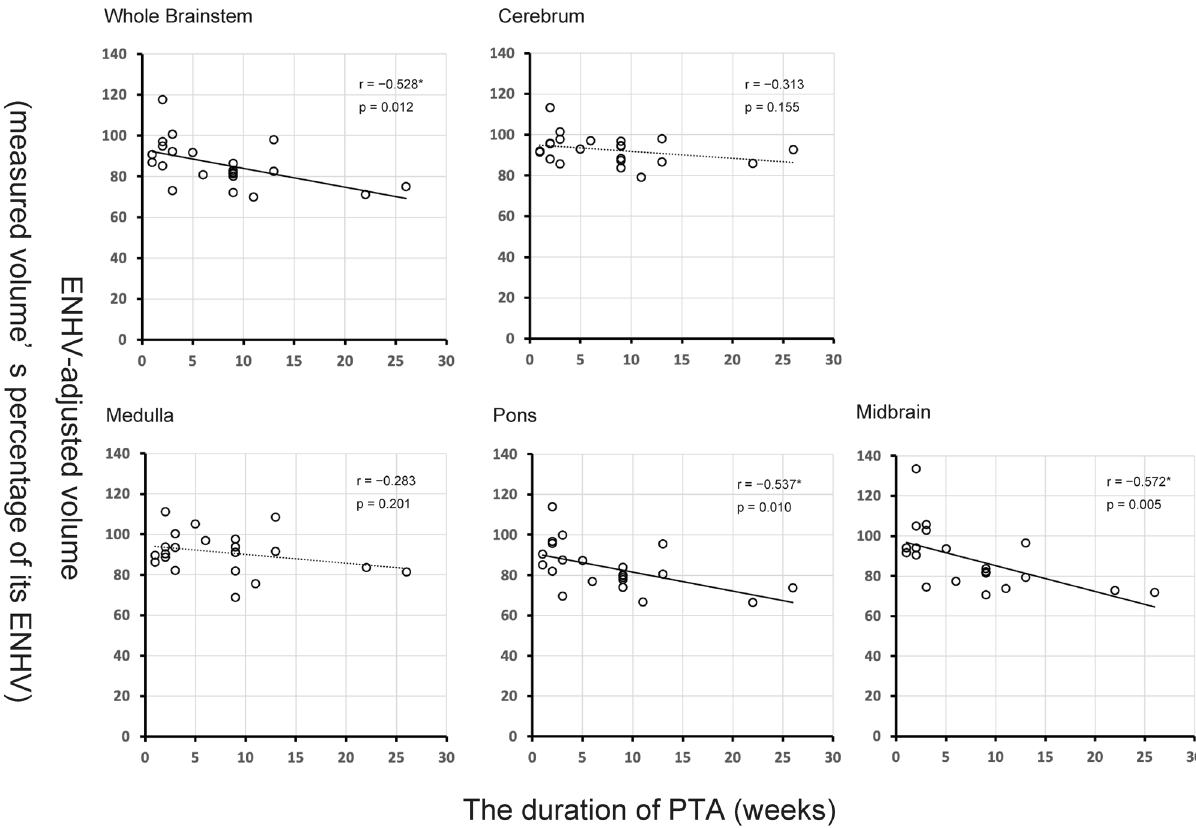
Figure 2. The duration of PTA and ENHV-adjusted volume in 22 DAI patients. The negative correlation between the duration of PTA and ENHV-adjusted volume was significant at P < 0.05 in the whole brainstem (r = − 0.528, P = 0.012), pons (r = − 0.537, P = 0.010), and midbrain (r = − 0.572, P = 0.005) but not in the cerebrum ( r = − 0.313, P = 0.155) or medulla (r = − 0.283, P = 0.201). *Significant at P < 0.05. PTA Posttraumatic amnesia, ENHV Expected normal healthy volume, DAI Diffuse axonal